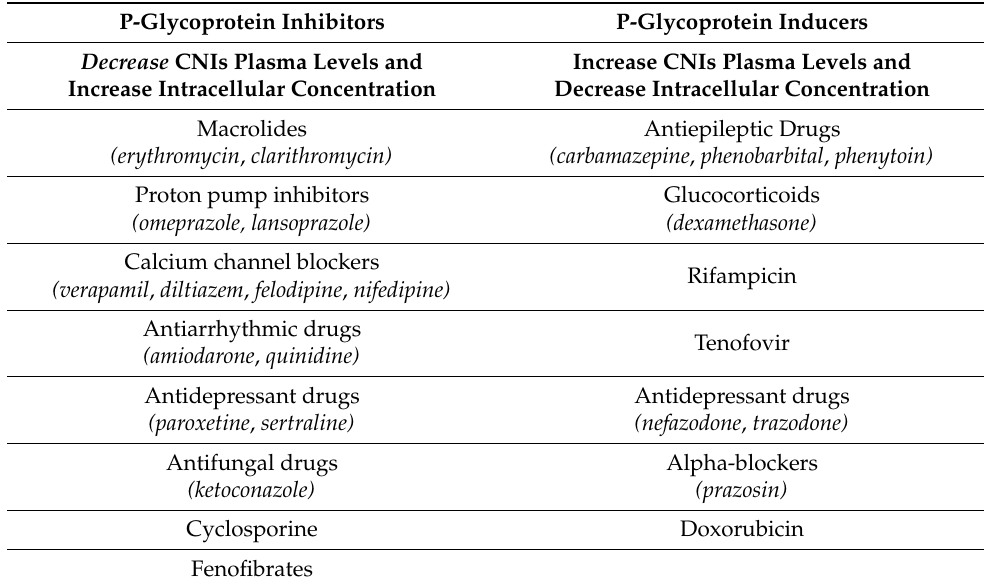
Table 2. Several factors can inhibit or increase the activity of P-glycoprotein, which regulates the intracellular concentration of CNIs. This protein can limit an excessive intracellular concentration of toxins and drugs, including CNIs, increasing their blood concentration. CNIs, calcineurin